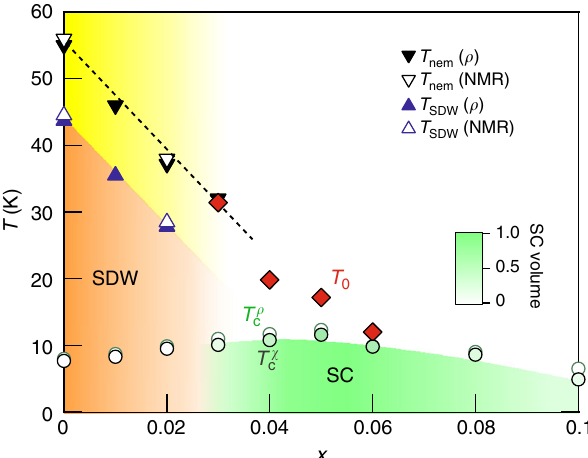
Fig. 5 Temperature-doping phase diagram of Na 1 − x Li x FeAs. T SDW , T nem , T ρ c , and T χ c were obtained by our transport, magnetization, and NMR measurements which turn out to be consistent one another. The emerging phase at T 0 before entering the bulk SC state is seemingly connected to the nematic transition at lower dopings. The shade of green below T c schematically represents the SC volume fraction obtained from Fig. 1c